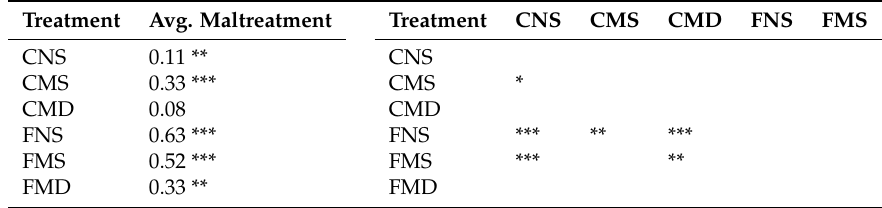
Table A10. Absolut Misreporting of Type M Patients across Experimental Conditions.